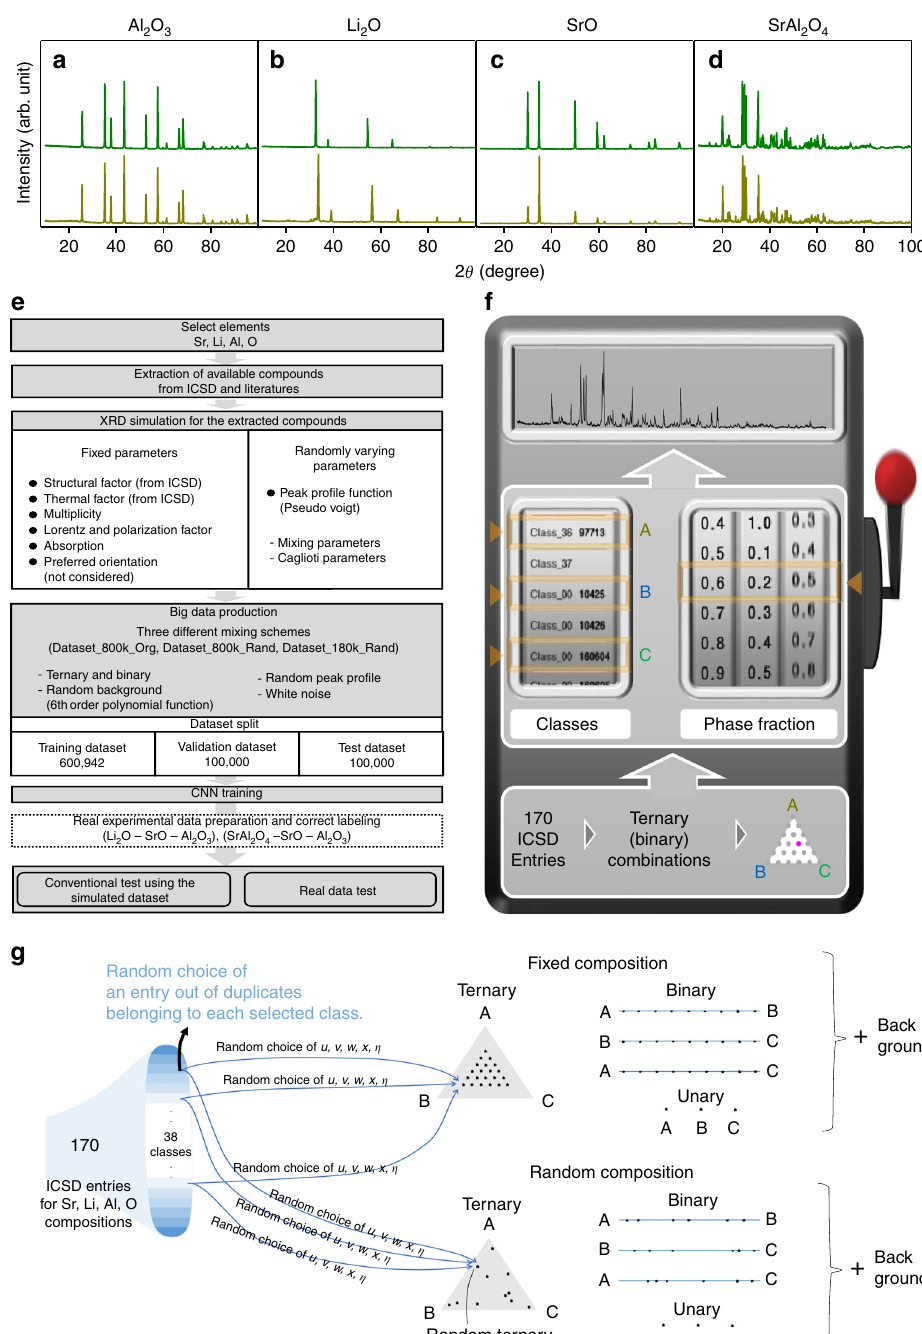
Fig. 3 XRD data preparation protocol. Comparison between experimental and simulated XRD patterns for a Al 2 O 3 , b Li 2 O, c SrO, and d SrAl 2 O 4 . Green and brown lines stand for experimental and simulated XRD patterns, respectively. e A fl ow chart for the overall dataset preparation. f The brief scheme of constituent compound selection for the binary and ternary combinatorics. g A schematic for detailed mixture preparation procedures. There are two independent mixture composition determination protocols: fi xed (evenly distributed) composition selection (upright) and random selection (downright). Each of these protocols leads to a total of 38 C 3 × 21 + 38 C 2 × 9 + 38 C 1 (183,521) different mixtures (Dataset_180k_rand). To produce 800,942 mixtures (Dataset_800k_org and Dataset_800k_rand), stochastic repetitive choices are allowed for mixtures consisting of constituents with multiple variants Simple mathematics might lead to quadruple repetitions per each mixture on average (i.e., 800,942/183,521 ≒ 4.36). However, the same mixtures (i.e., the same constituents and the same fractions) could be scarcely found in the entire dataset, because we adopted repetitive choices only for some mixtures with highly